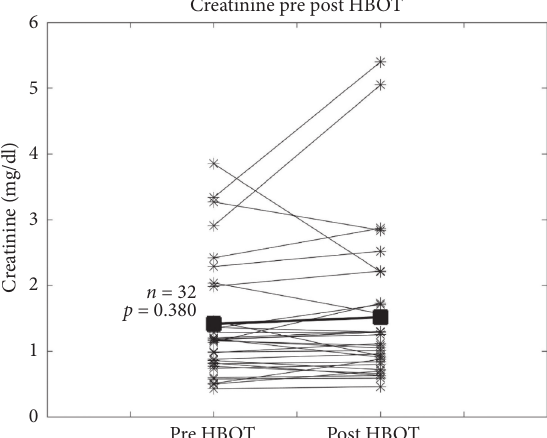
Figure 1: Creatinine levels before and after hyperbaric oxygen therapy (HBOT). Measurements were taken within 60 days of starting and ending HBOT. Asterisks show the individual results, and the squares are the mean. The paired Student’s t-test p value was used to obtain the p